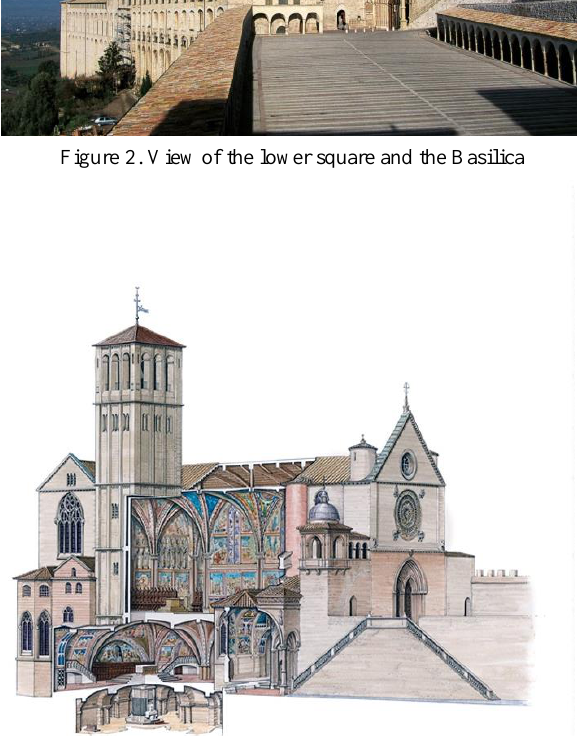
Figure 3. View of the 3 layers of the Basilica (left) and the related plants (up-right: higher Basilica, down-right: lower Basilica)